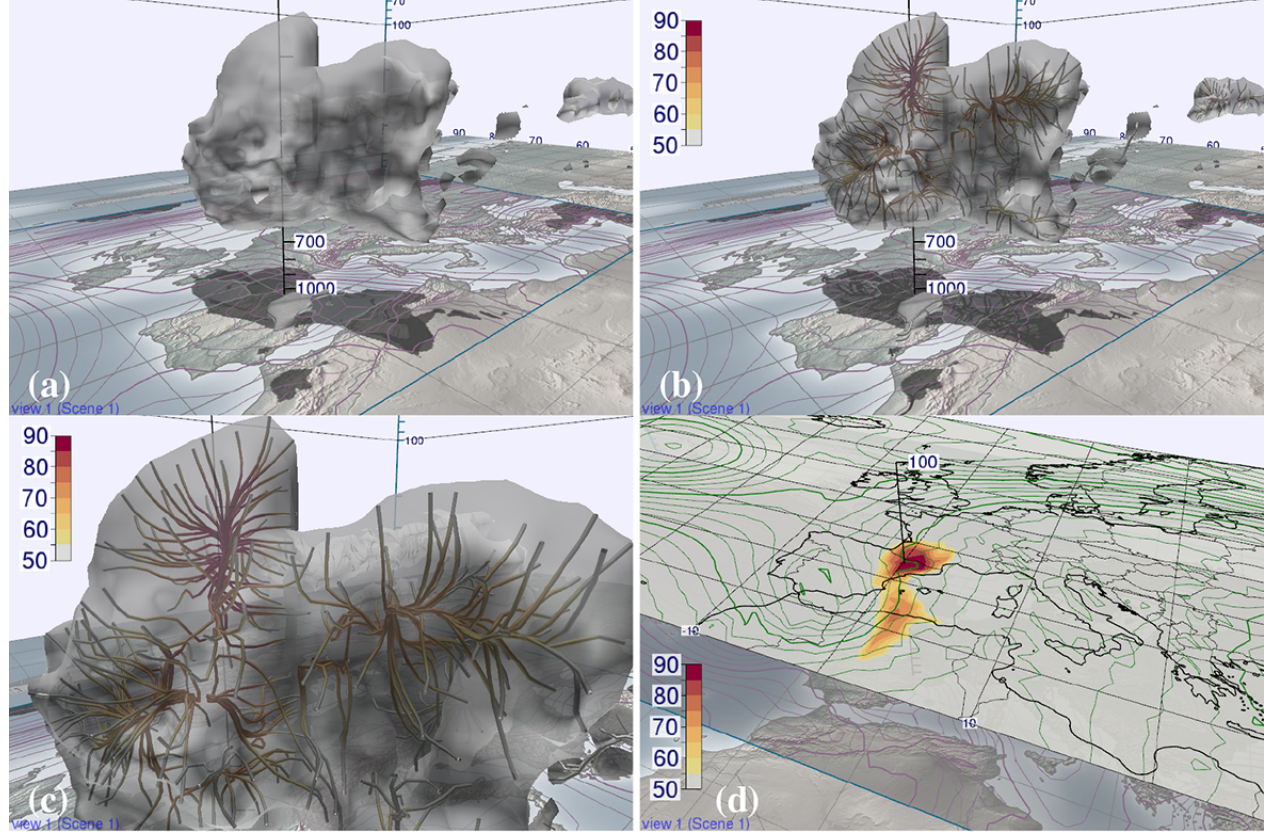
Figure 8. Normal curves help to analyse the topology of 3-D scalar fields. They reveal the distribution of data values in a subdomain enclosed by a 3-D isosurface and enable fast identification and tracking of local extrema. (a–c) Probability of cloud ice water content exceeding 0.01gkg − 1 . The white transparent isosurface shows 40% probability. Colour coding in %. (d) Details of the identified maximum are inspected with a horizontal section at 250hPa. Forecast from 00:00UTC, 17 October 2012 valid at 12:00UTC, 20 October 2012 (animated version of this figure in the Supplement at